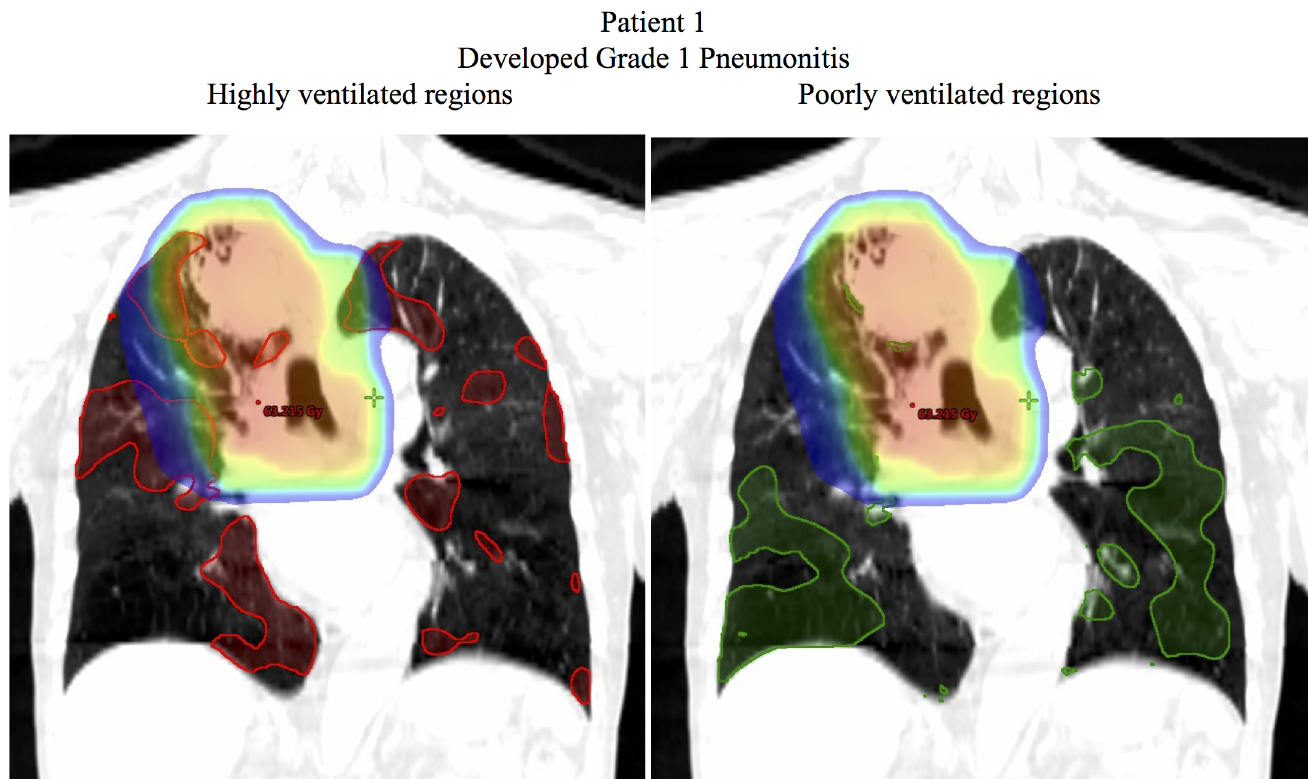
Fig 5. Example case of a patient without severe radiation pneumonitis (Grade 1). The red contour indicates the highly ventilated region (70th–100th percentiles) and the green contour indicates the poorly ventilated region (0–30th percentiles). The dose > 5 Gy is shown.